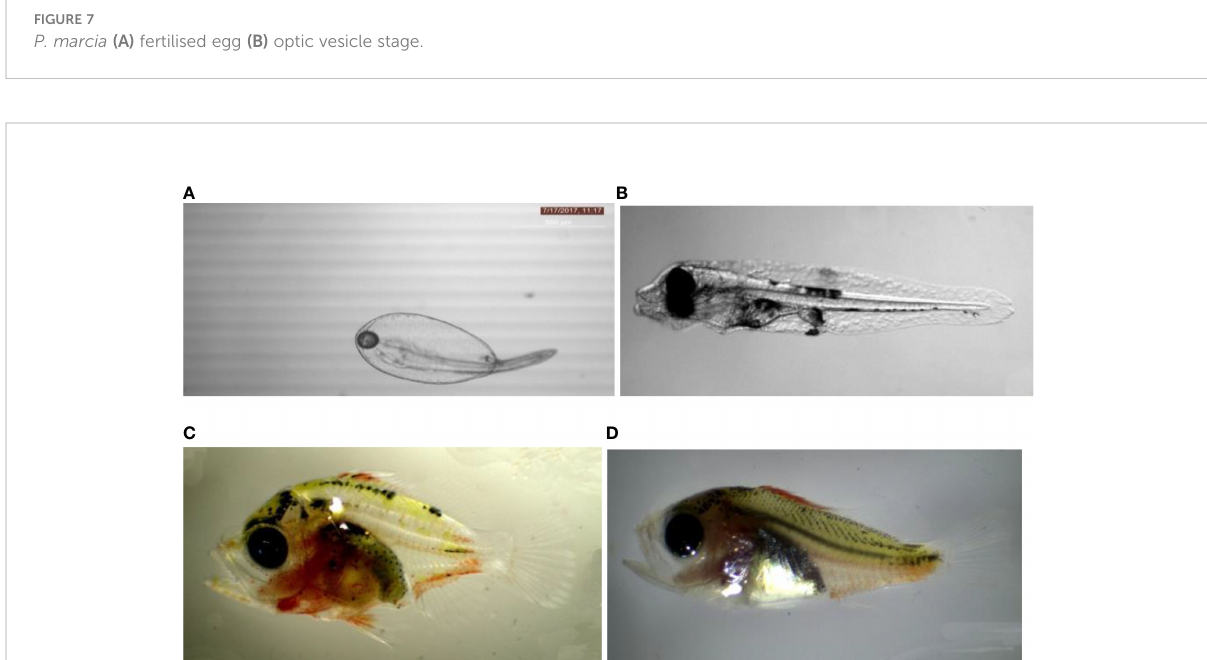
FIGURE 8 Larval development of Pseudanthias marcia from hatchling to 35 dph: (A) hatchling with yolk sac (B) 3 dph larvae, (C) 25 dph larvae, and (D) 35 dph larvae.